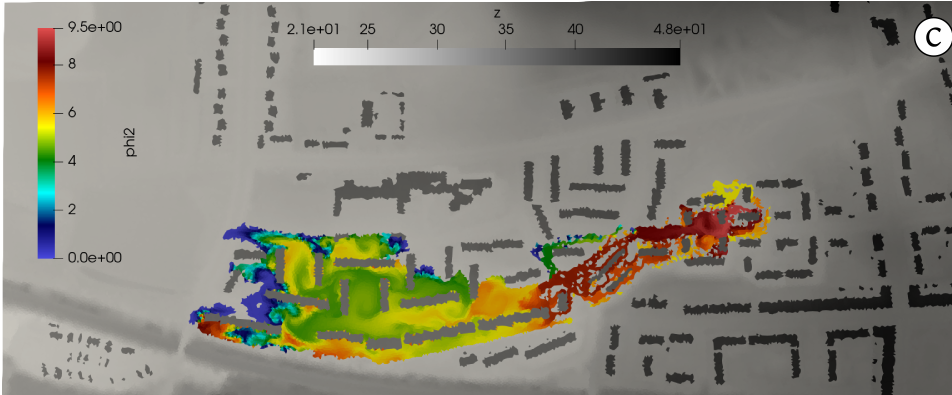
Figure 6. Case 1: Water ( a ) and pollutants ( b , c ) flood extent at t = 5 h.